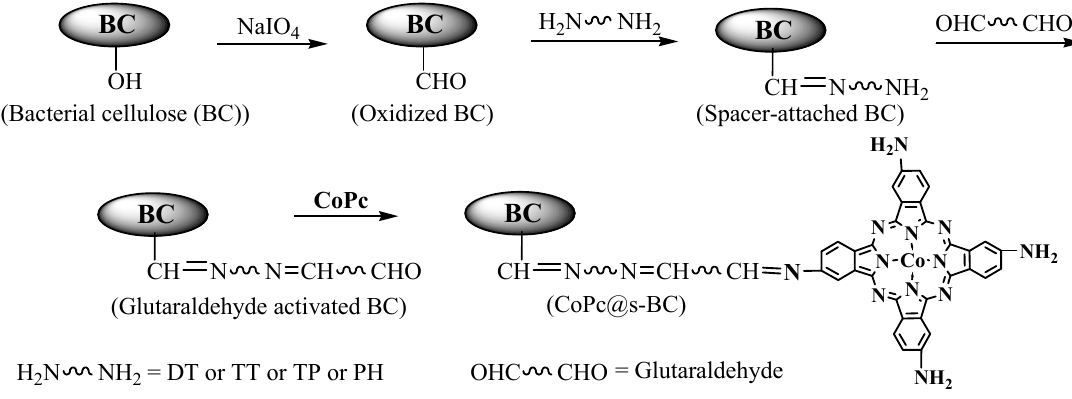
Figure 2. Synthesis route of spacer-incorporated, tetra-amino cobalt (II) phthalocyanine immobilized bacterial cellulose nanocomposites (CoPc@s-BC).